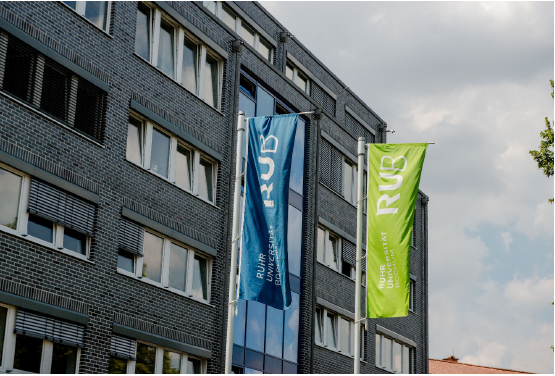
Figure 7 Researchers from the Center for Religious Studies (CERES) will continue to work on the KHK’s